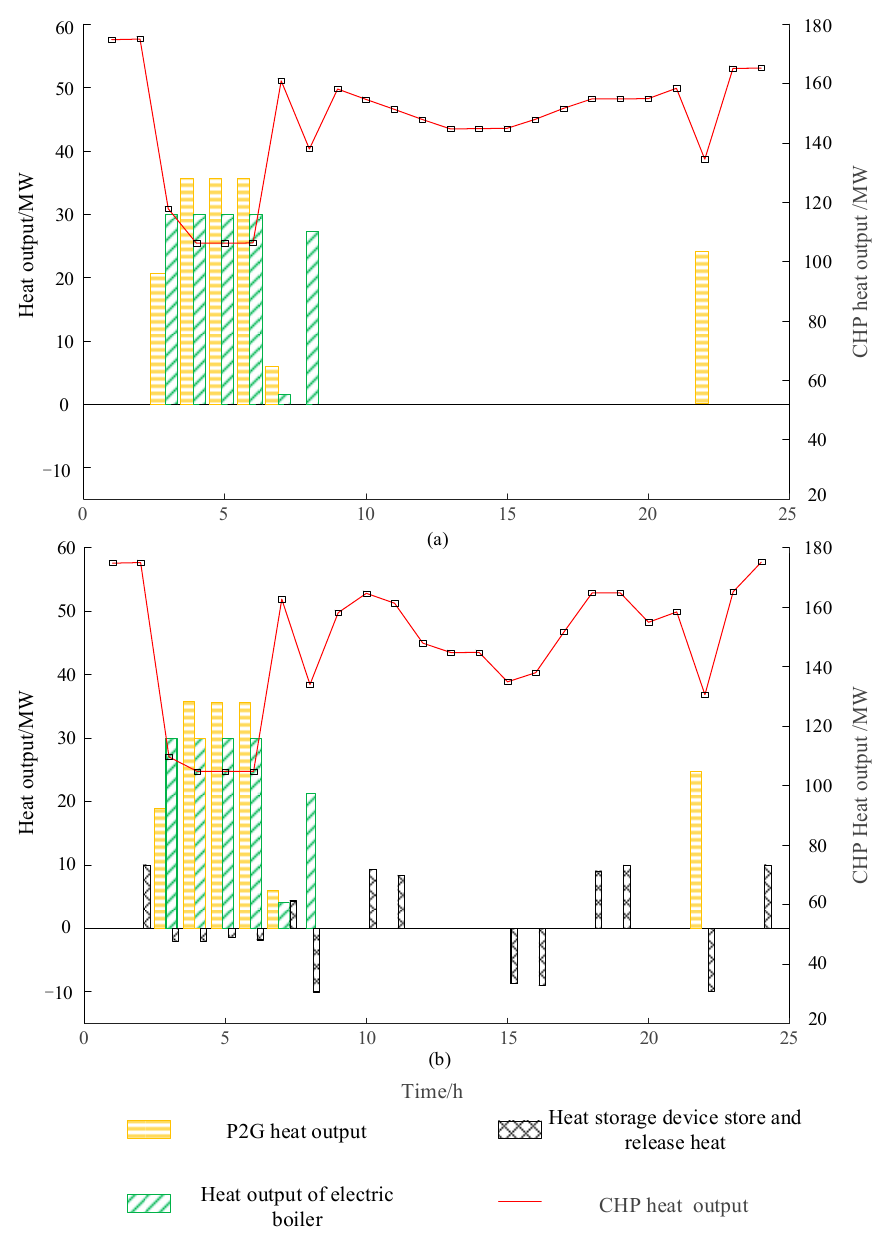
Figure 9. Effect of heat energy storage on heat output of the system. ( a ) Without heat storage device; ( b ) With heat storage device .